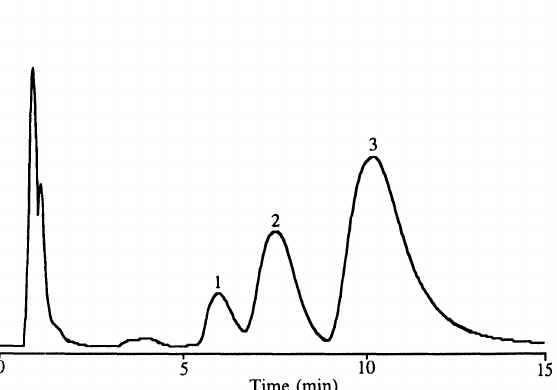
FIG. 2. Typical reversed-phase chromatogram of incubation samples of histamine (2.7mM) with 1001M FeCI3, 1001M EDTA, 100tM ascorbic acid and mM H202. This sample was incubated for 3 h at 37C and revealed products at 6.0 (peak 1) and 7.6 min (peak 2) next to histamine which eluted at 10.2 min (peak 3). The paxis represents the absorbance intensity (arbitrary units), the x-axis represents the retention time